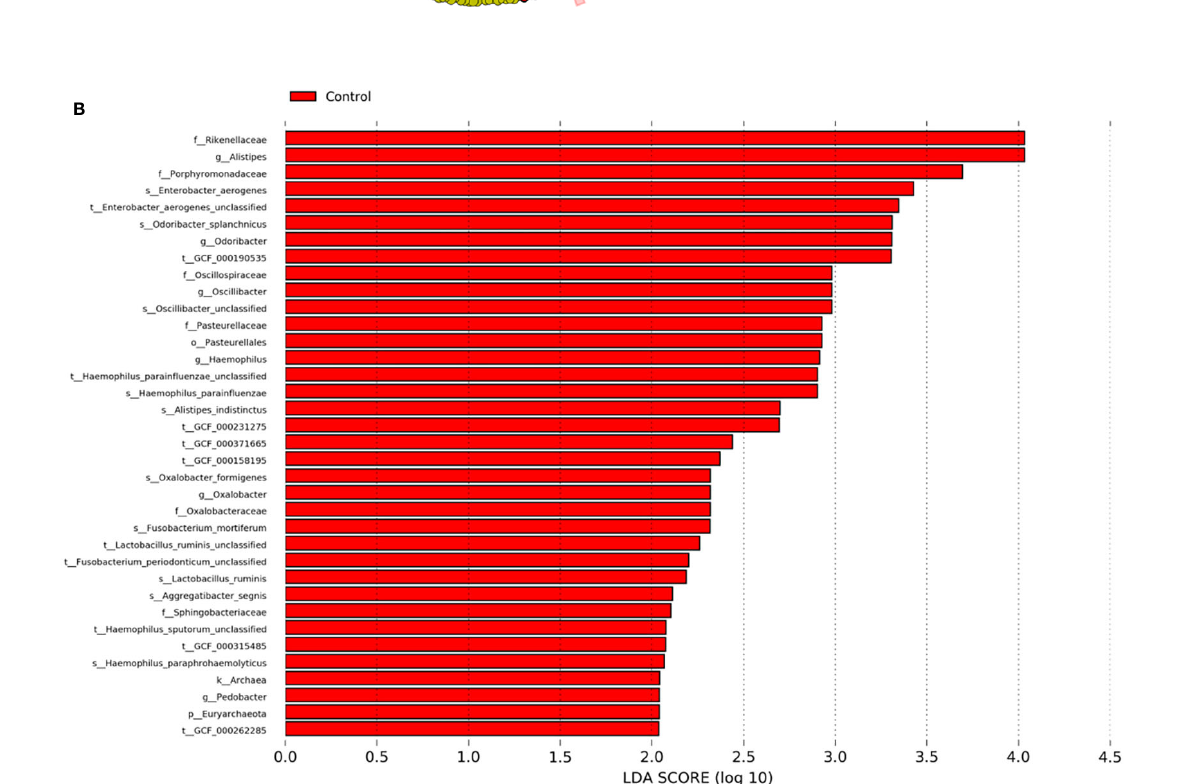
FIGURE 5 | Intestinal microbiota pro fi les in psoriasis patients. (A) Cladogram generated from the LEfSe analysis indicating the phylogenetic distribution of the microbiota of psoriasis and control groups from phylum to genus. (B) Histogram of LDA scores to identify differentially abundant bacteria between patients and controls (LDA score >